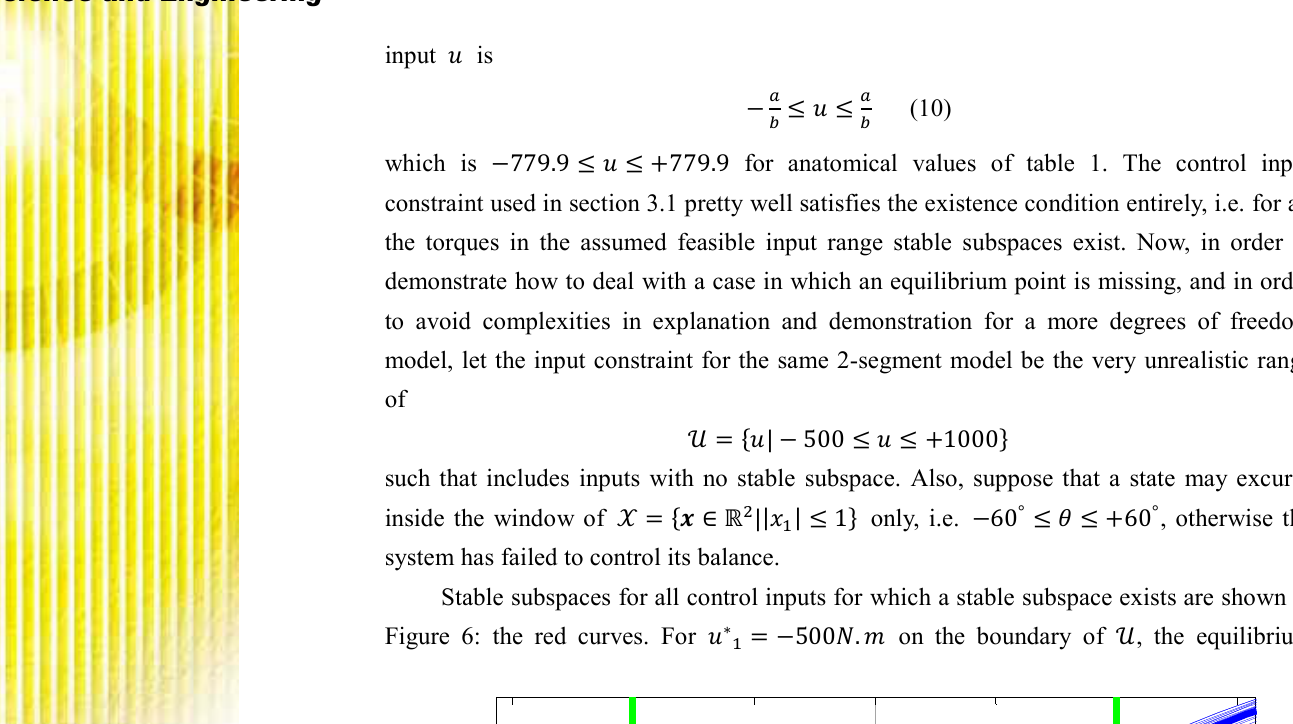
Figure 6: the red curves. For (cid:1873) (cid:1499)